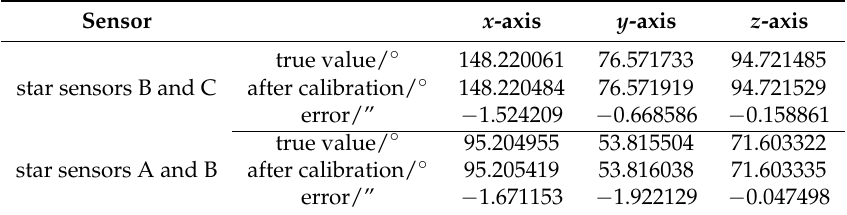
Figure 6. The angle of coordinate axis of two star sensors. ( a ) x -axis angle between star sensors B and C, ( b ) y -axis angle between star sensors B and C, ( c ) z -axis angle between star sensors B and C, ( d ) x -axis angle between star sensors A and B, ( e ) y -axis angle between star sensors A and B, ( f ) z -axis angle between star sensors A and B. Table 3. The angle of coordinate axes between star